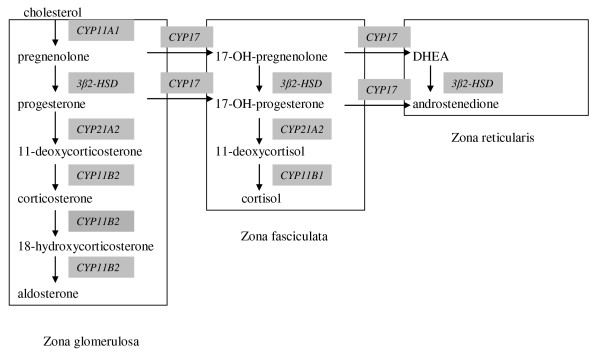
Schematic presentation of steroidogenesis. 3BHSD, 3-hydroxysteroid-dehydrogenase; CYP11B1, 11ß-hydroxylase; CYP11B2, 11 and 18-hydroxylase; CYP17, 17-hydroxylase and 17,20-hydroxylase; CYP21, 21-hydroxylase.